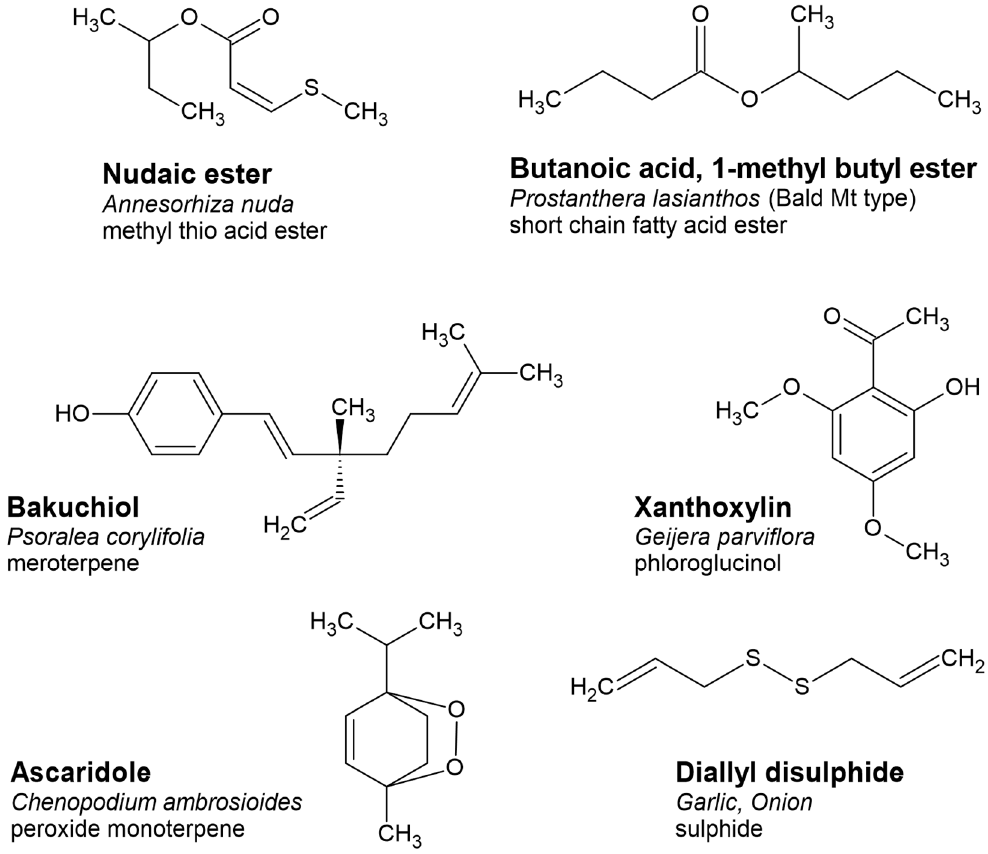
Figure 7. Unusual essential oil components.